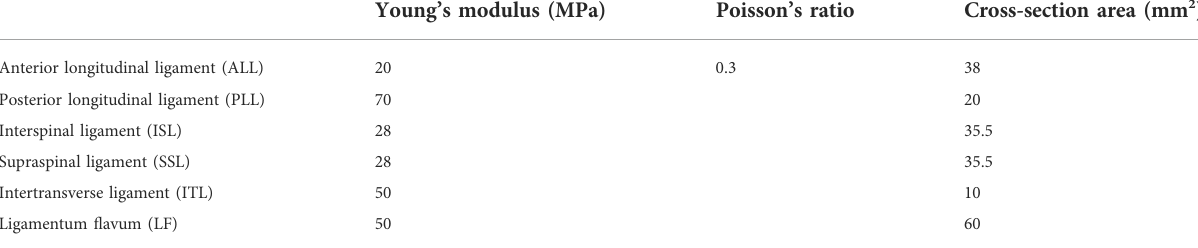
TABLE 4 Cross-section area of every ligament and mechanical